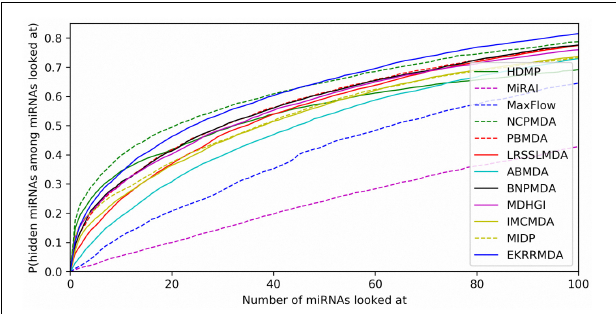
FIGURE 5 | Performance comparisons between EKRRMDA and other prediction models in terms of CDF of ranks based on local LOOCV.